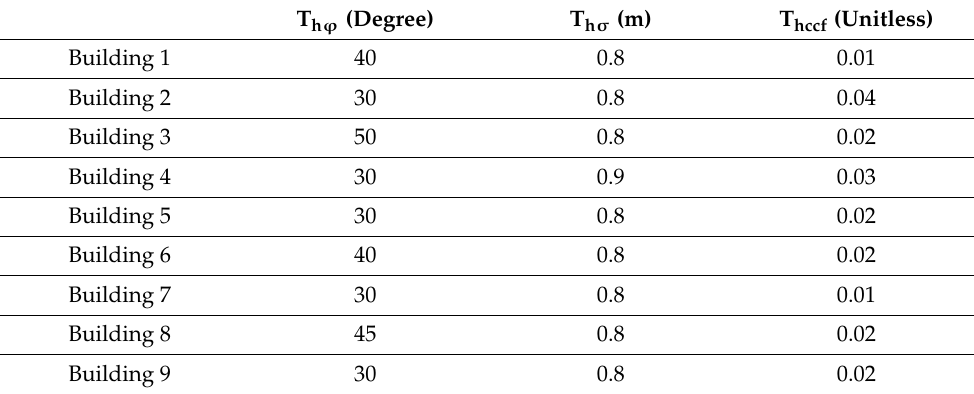
Figure 7. Algorithm flowchart for smart calculation of employed thresholds; Th i (Th_Fy, Th_Sd, Th_Cf) are the used thresholds; ε i are last shifts applied on thresholds; e i : are difference of number of points detected by thresholds before applying the shifts ε i . Table 1. Values of calculated thresholds for the three buildings represented in Figure 3 in addition to five other buildings from Vaihingen point